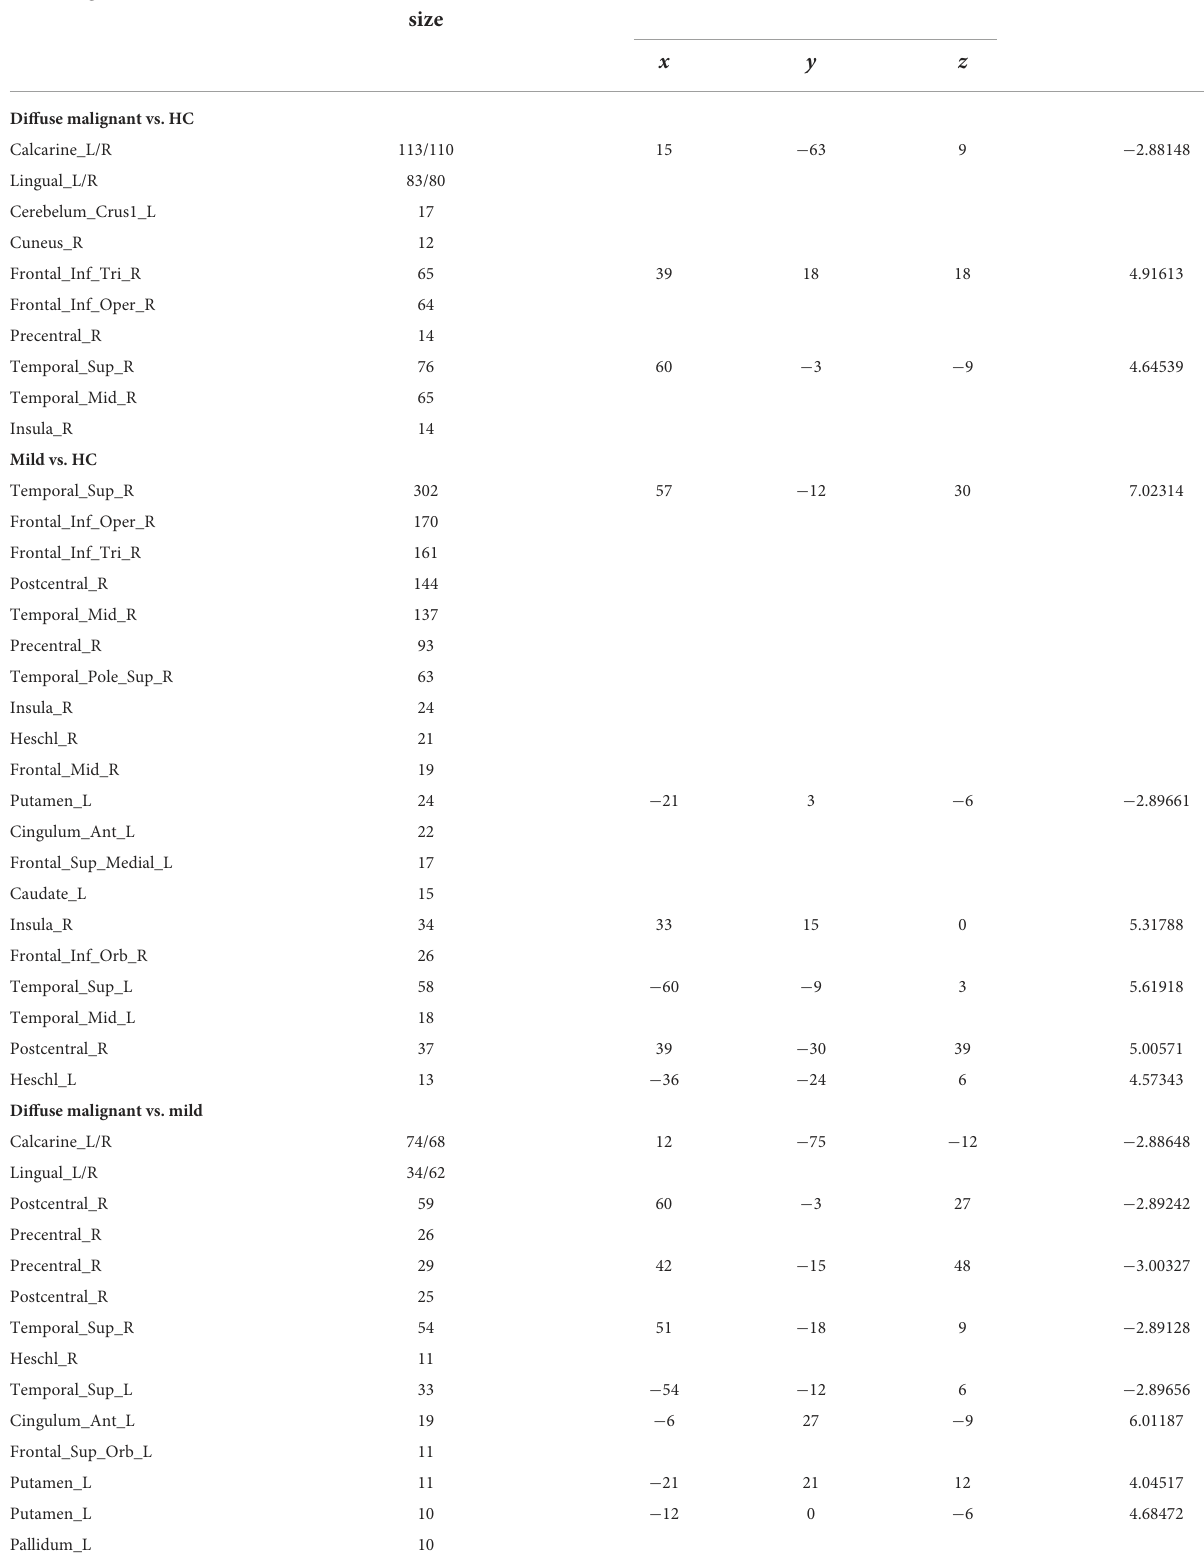
MNI coordinates Peak t -value size x y z